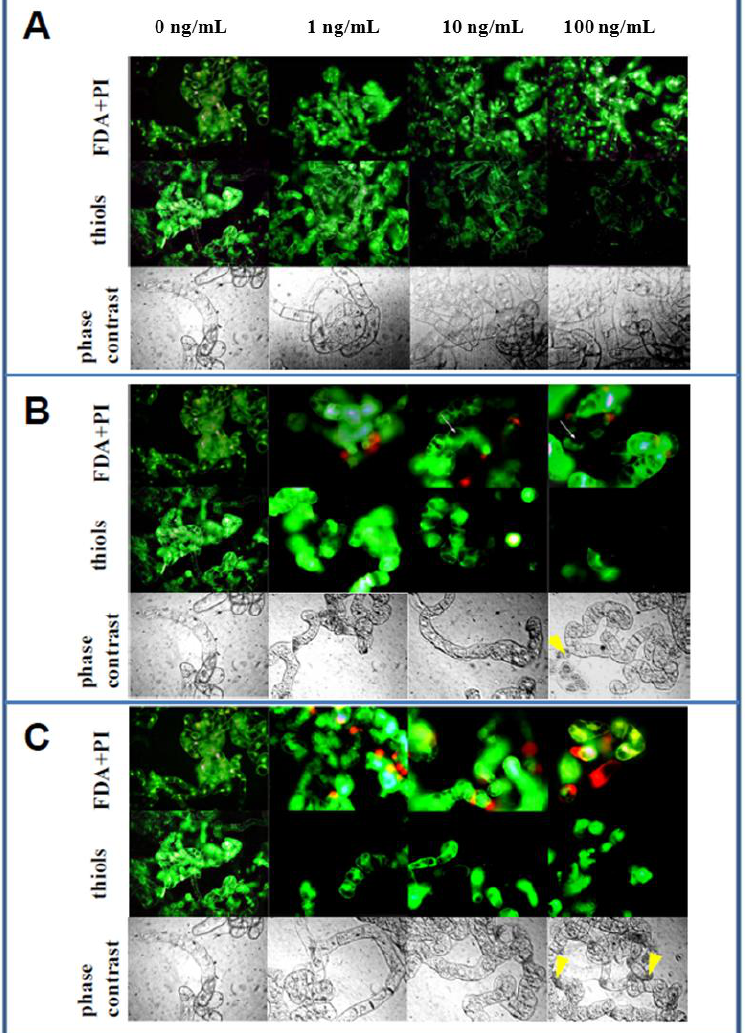
O nanoparticles (NPs) and modified 2 3